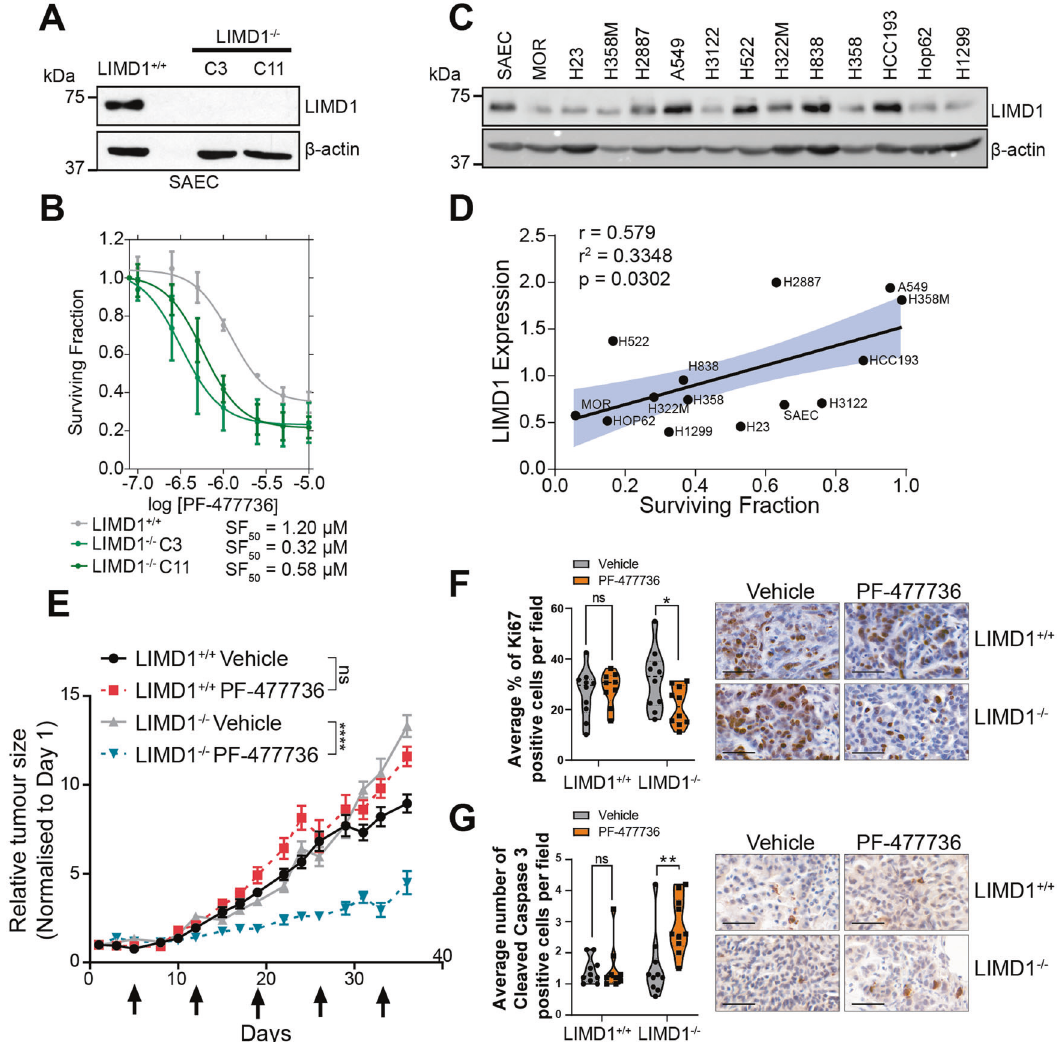
Fig. 4 PF-477736 treatment is proof-of-concept inhibitor of LIMD1- de fi cient lung cancers. A Immunoblot of isogenic LIMD1 − / − small airway epithelial cells (SAEC) and control. B Dose – response of PF-477736 in isogenic LIMD1 − / − SAEC. Cells were treated twice prior to measuring cell viability and calculating surviving fraction ( n = 3). C Immunoblot of LIMD1 in a panel of lung adenocarcinoma cell lines (representative blot from n = 3). D Pearson ’ s correlation coef fi cient between LIMD1 protein expression and surviving fraction of indicated cell line after treatment with 1 µM PF-477736. E Relative tumour growth of subcutaneous A549 isogenic xenografts implanted into the fl ank of NOD/SCID mice. Mice were treated twice on indicated days with vehicle or PF-477736 (7.5 mg/kg per dose) ( n = 10 per group). F , G Immunohistochemical staining and scoring of Ki67 ( F ) and cleaved caspase-3 ( G ) in mouse xenograft tumours ( n = 10 per group, two-way